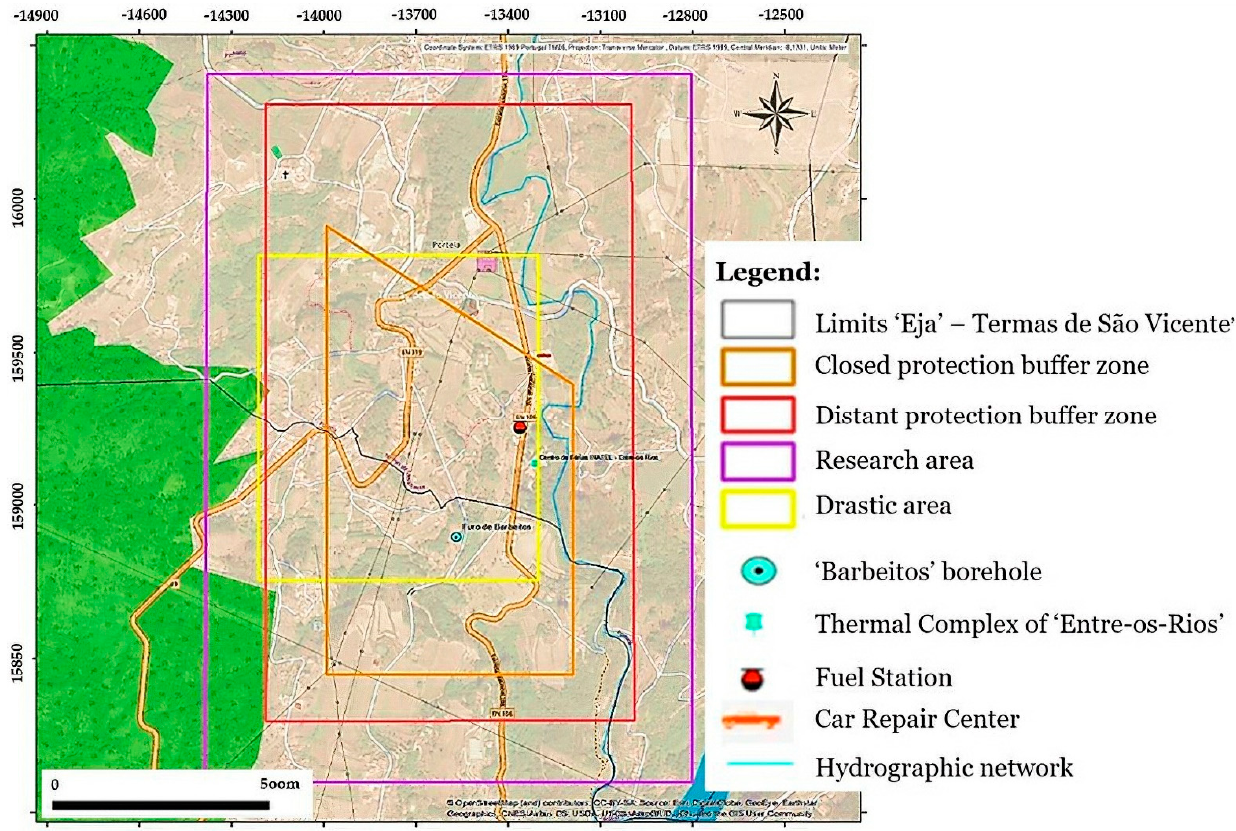
Figure 2. Location map of the ‘Barbeitos’ borehole and protection buffer zones and their conditions. The region is part of the Iberian Massif’s Central Iberian Zone (CIZ) [66,67]. From a geomorphological standpoint, the region is shaped by a dense network of deeply settled watercourses that flow into the Douro river after drawing pathways that are quite sinuous